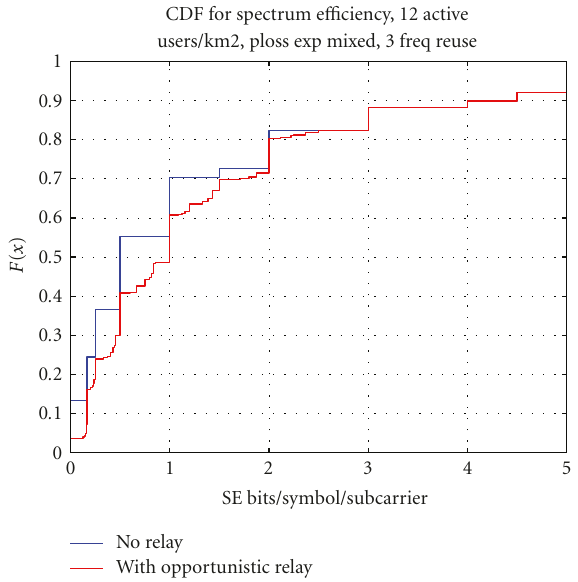
Figure 7: Spectrum e ffi ciency for opportunistic relays -CDF plot.